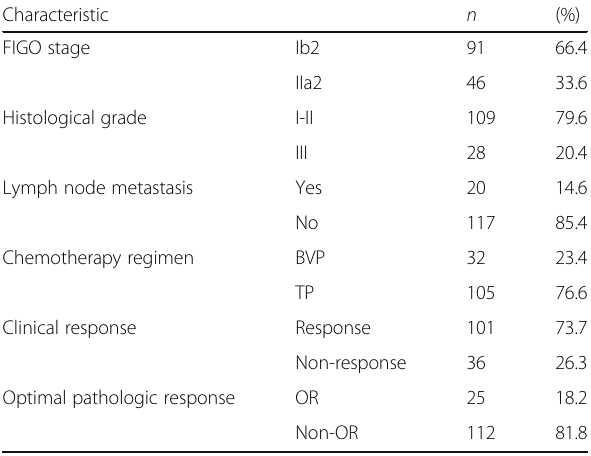
Table 1 Patient